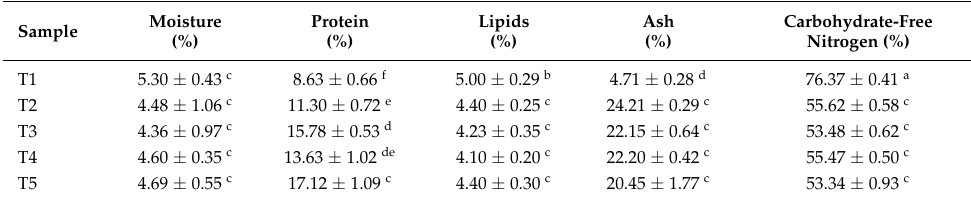
Table 2. Chemical composition 1 of corn snacks: 100% CM (T1), 80% CM–20% UMF (T2),